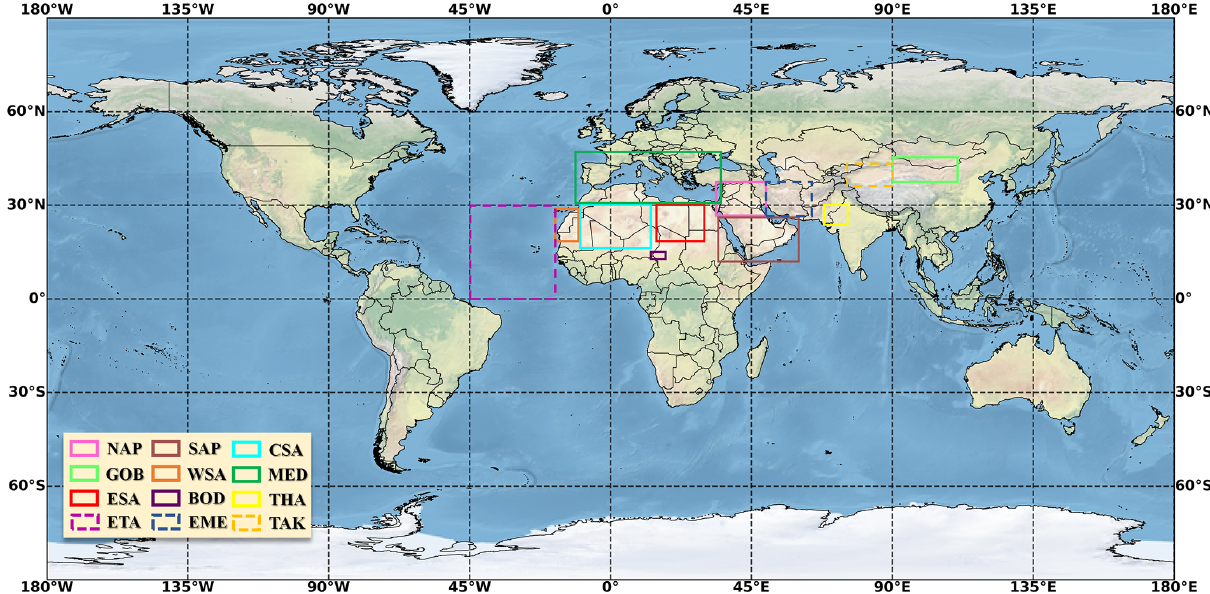
Figure 7. Regions of interest for seasonal and regional analysis: northern Arabian Peninsula (NAP), southern Arabian Peninsula (SAP), central Sahara (CSA), Gobi Desert (GOB), western Sahara (WSA), Mediterranean (MED), eastern Sahara (ESA), Bodélé Depression (BOD), Thar Desert (THA), eastern tropical Atlantic (ETA), eastern Middle East (EME) and Taklamakan Desert (TAK). Solid rectangles indicate the regions included in the regional analysis (Sect. 3.3), while solid and dashed rectangles are for the seasonal